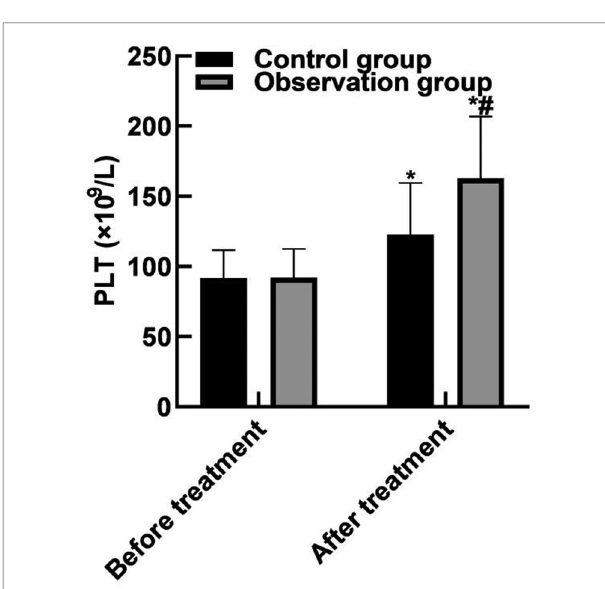
FIGURE 5 | Comparison of liver function indicators. Note: Compared with before treatment, * P <0.05; Compared with the control group, # P